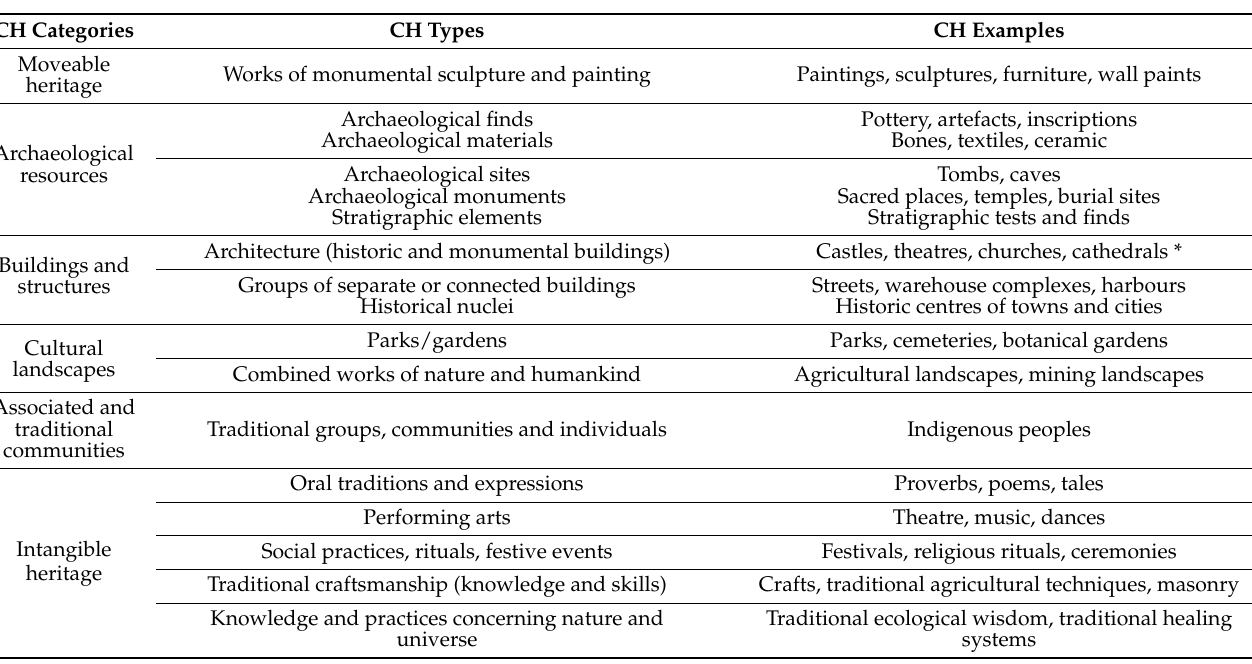
Table 2. ARCH Classification for CH included in HAs: Categories; Types and